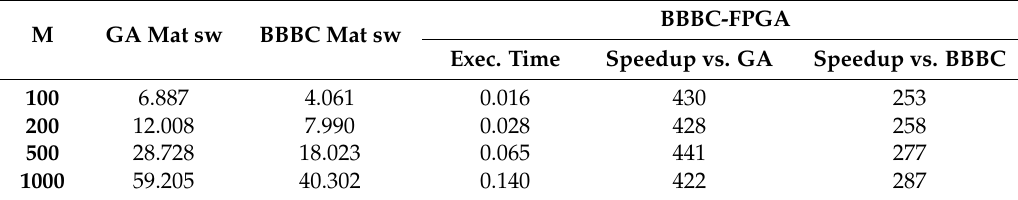
Table 6. Computation time in (s) for GA, BBBC (in sw), and BBBC-FPGA (proposed